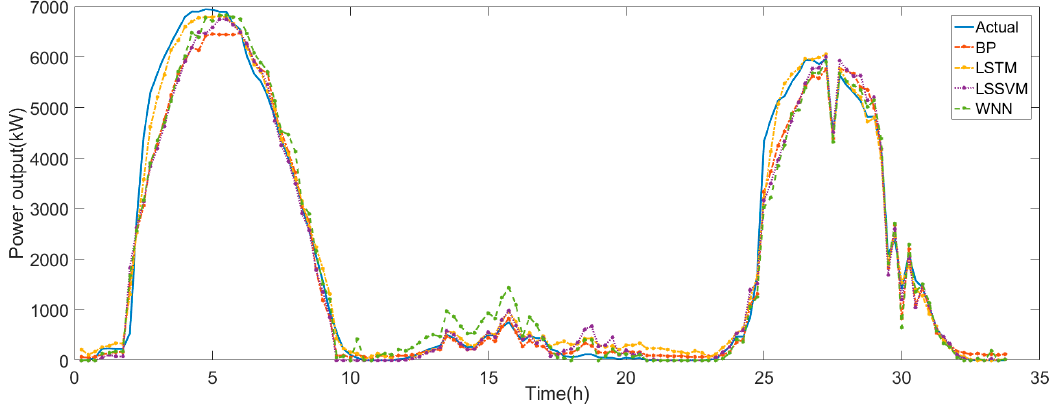
Figure 11. Short-term PV power forecasting in summer by various algorithms.